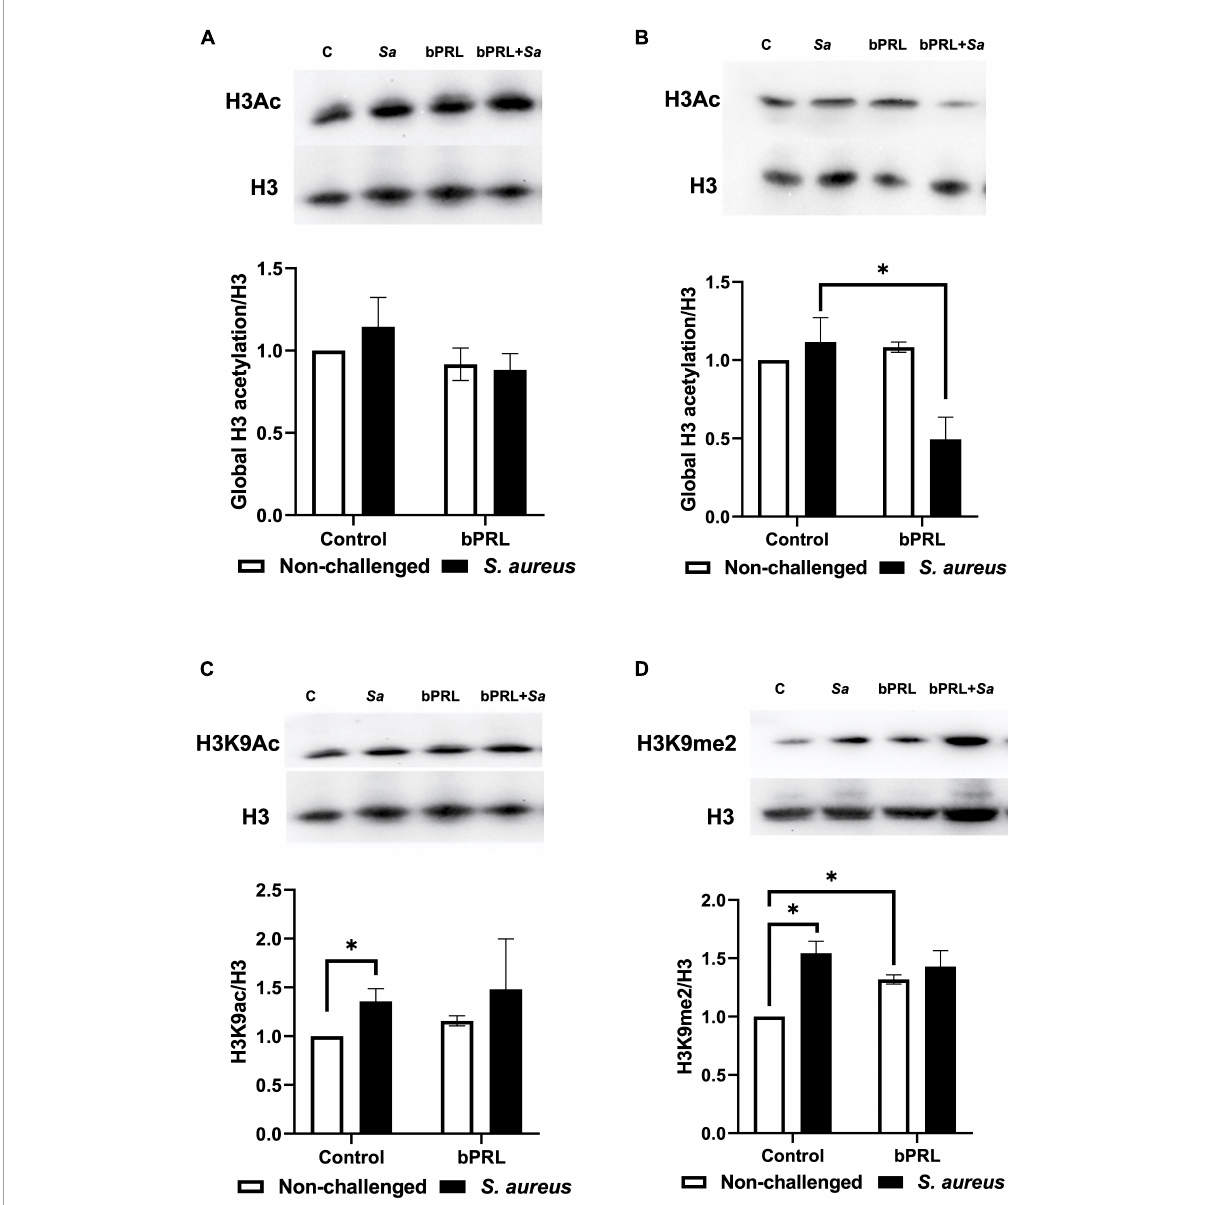
FIGURE1 Regulation of histone H3 marks by bPRL in bMECs during S. aureus challenge. bMECs were treated with bPRL (5 ng/ml), and cells were or not challenged for 2 h with S. aureus (MOI 30:1). Densitometrical analysis of the immunoblots that shows the relative expression of global H3ac regarding the total H3 in bMECs treated 12 h (A) and 24 h (B) with bPRL and challenged or not challenged. Densitometrical analysis of immunoblots that shows the relative expression of H3K9ac mark (C) and H3K9me2 mark (D) regarding the total H3 in bMECs treated 12 h with bPRL and challenged or not challenged. C, bMECs without any treatment; bPRL, bMECs treated 12 h or 24 h with bPRL (5 ng/ml); bPRL + Sa , bMECs treated 12 or 24 h with bPRL (5 ng/ml) and challenged with S. aureus for 2 h (MOI = 30:1); Sa , bMECs only challenged with S. aureus (MOI = 30:1). Representative western blots are shown above each graph. Bars show the mean ± SE of optical density (arbitrary units, AU), considering the expression of control cells (bMECs without treatment) as 1 (data normalized) obtained from four independent experiments ( n = 4). The symbol “ ∗ ” indicates a significant change ( p ≤